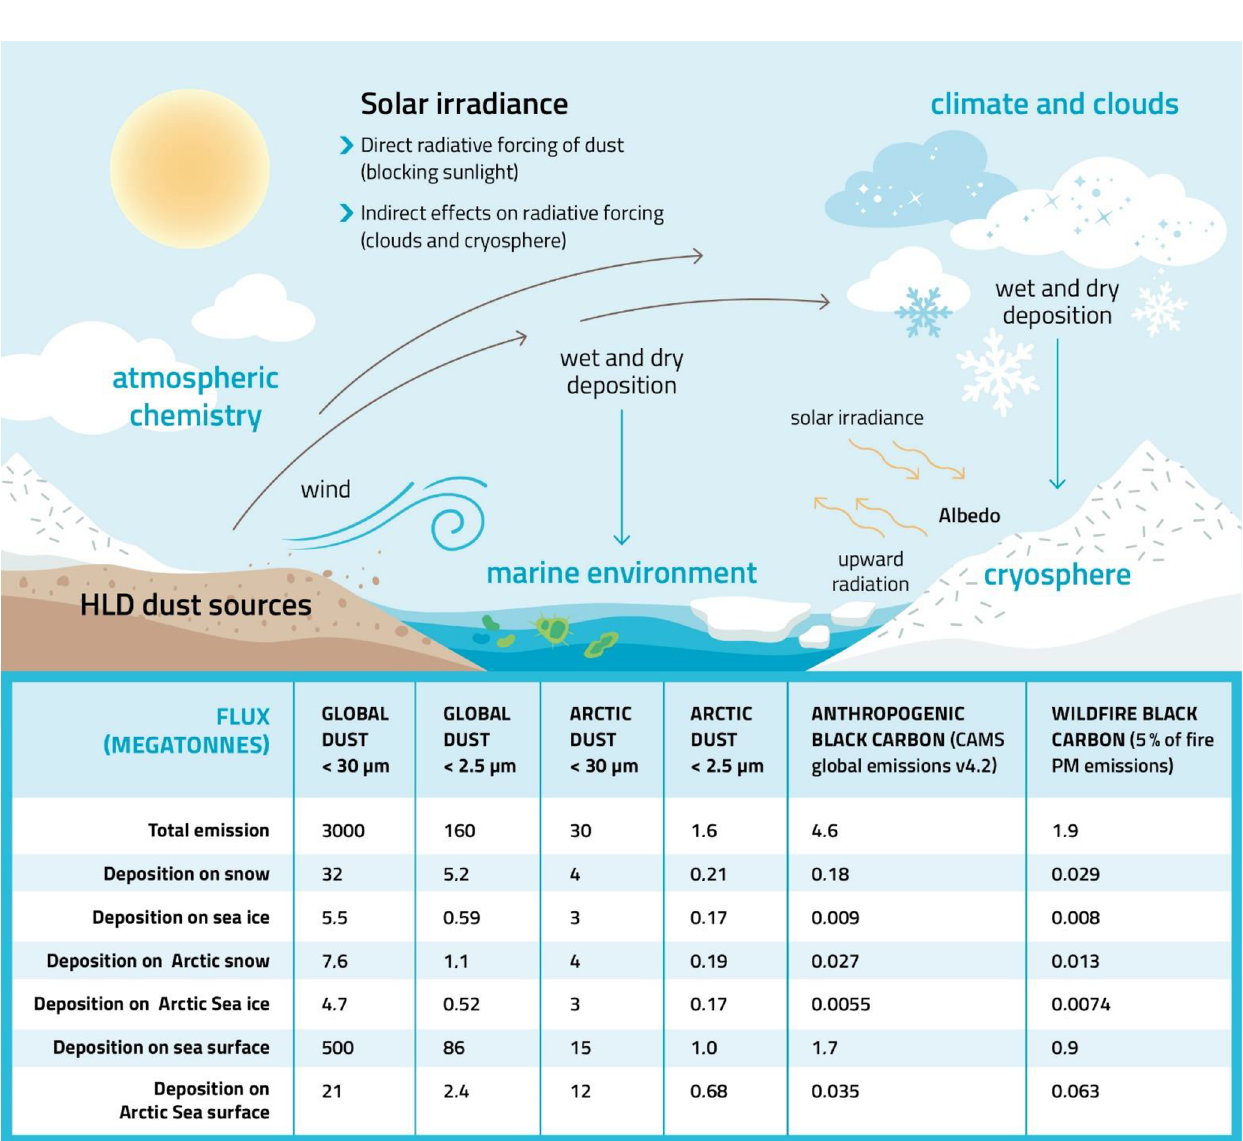
Figure 15. Climatic and environmental impacts of HLD include direct radiative forcing (blocking sunlight), indirect radiative forcing (clouds and cryosphere), as well as effects on atmospheric chemistry and the marine environment. The amounts of dust emission and deposition (Mt) of global and Arctic dust, as compared to black carbon, were estimated using the SILAM model (Sofiev et al., 2015). The black carbon emissions are based on the CAMS global anthropogenic emission dataset v4.2, and the wildfire black carbon emissions are based on the IS4FIRES fire emission model, equaling 5% of the total primary fire PM emissions of the